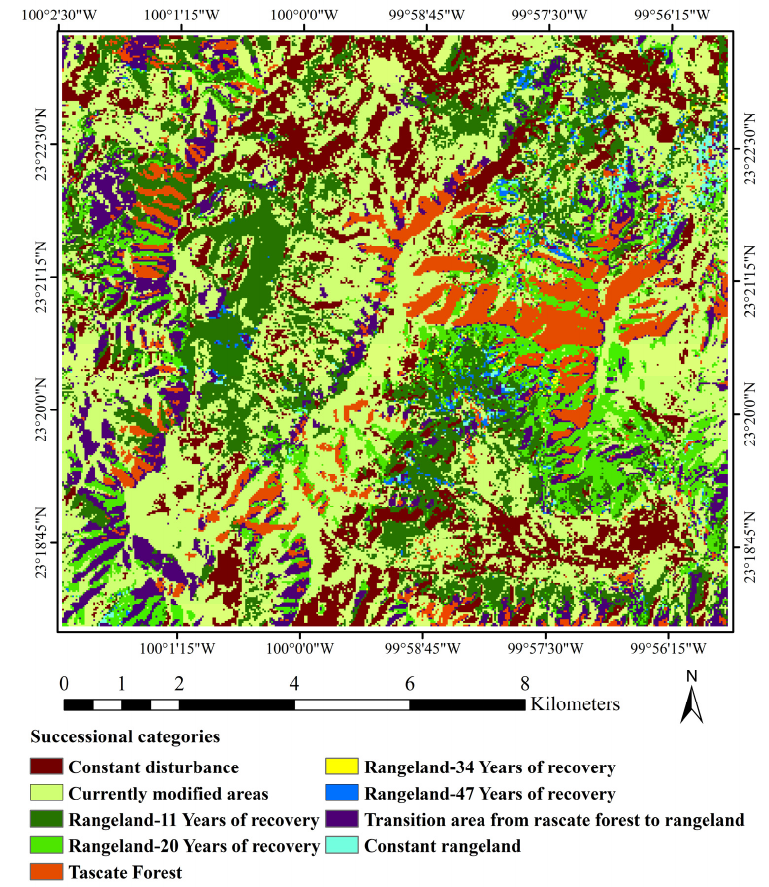
Figure 22. Successional categories of coverage and changes in land use, El Llano y Anexas, Busta- mante, Tamaulipas, Mexico.